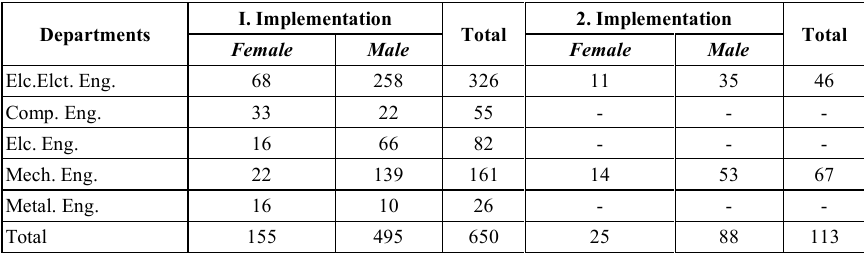
Table 1. Distribution of the Study Group with respect to Department and Gender I. Departments